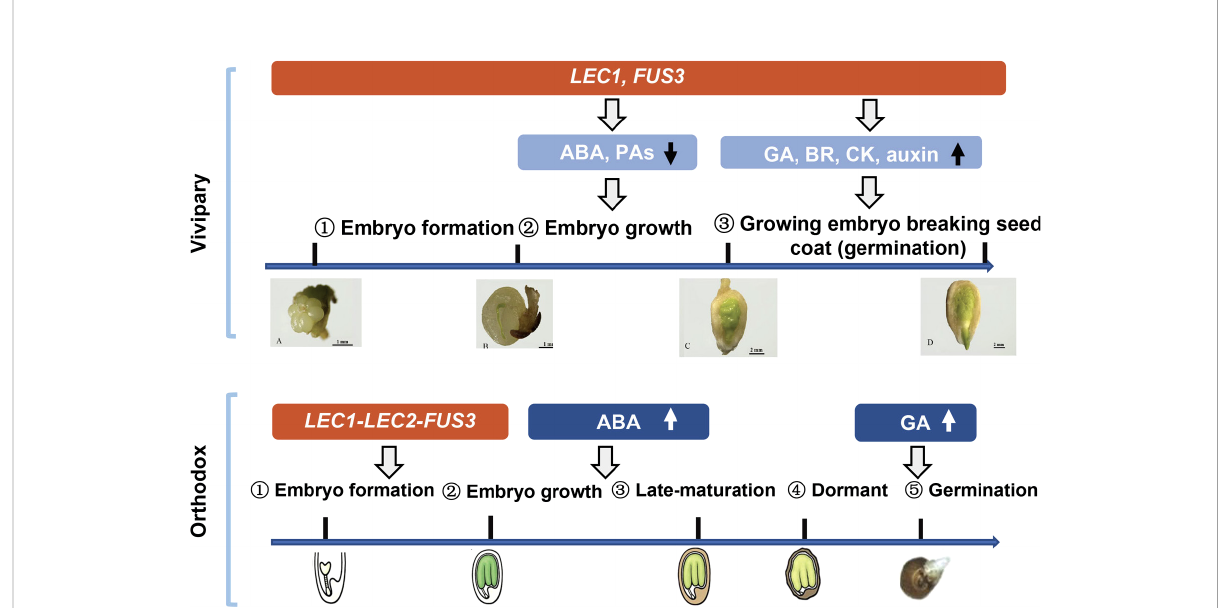
FIGURE 6 A schematic model compares the vivipary process to orthodox seed development and germination. The expression periods of key genes ( Lec1 , Lec2 , and FUS3 ) are shaded in red. Blue shaded area hormonal and proanthocyanidin (PA) metabolic pathways, and the arrows indicate up- or down-regulation. In vivipary species like K. obovata , only three stages up to hypocotyl breaking the seed coat (signifying germination) are shown; after that, the hypocotyl continues to grow, breaking the fruit coat, and elongates up to 20 – 30 cm. Scale bars are shown in the pictures. The representative orthodox seeds are from Arabidopsis, which is not drawn in